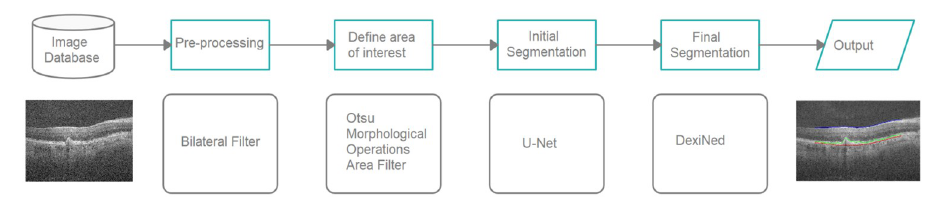
Fig 1. Flowchart of the segmentation